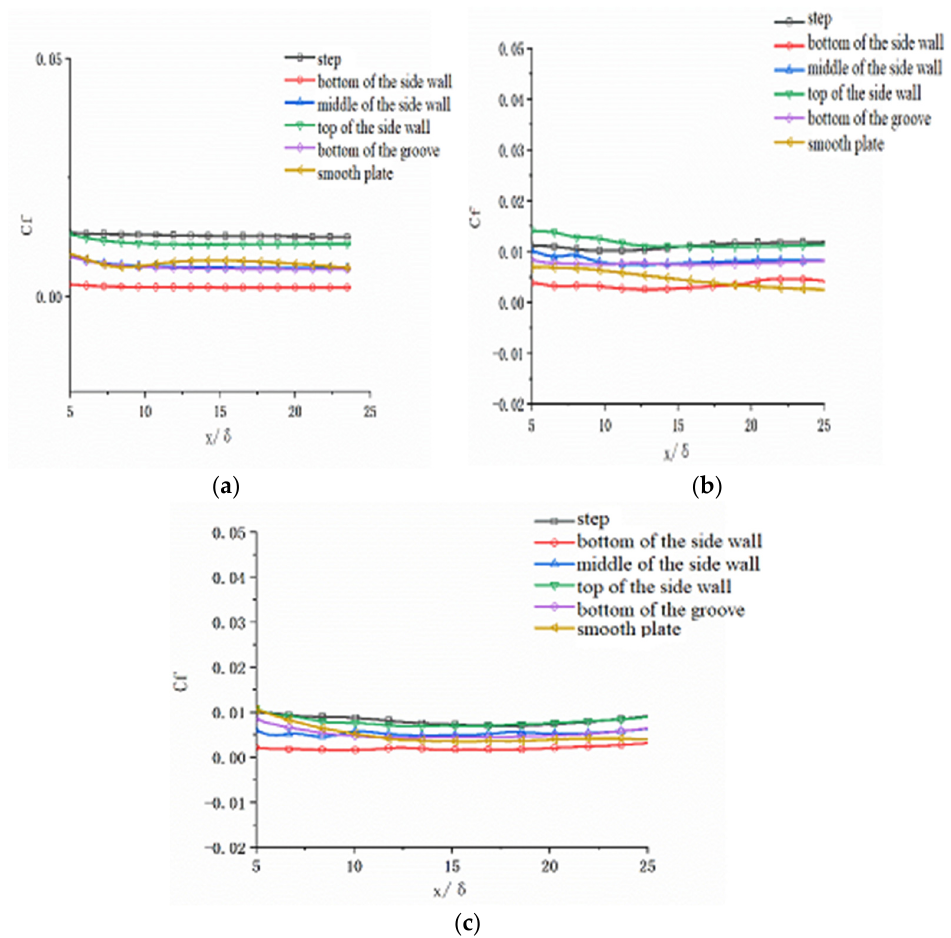
Figure 27. The shear stress coefficient distribution along the flow direction of rectangular groove plate under different Mach numbers; ( a ) 0.3 Ma; ( b ) 0.5 Ma; and ( c ) 0.8 Ma.